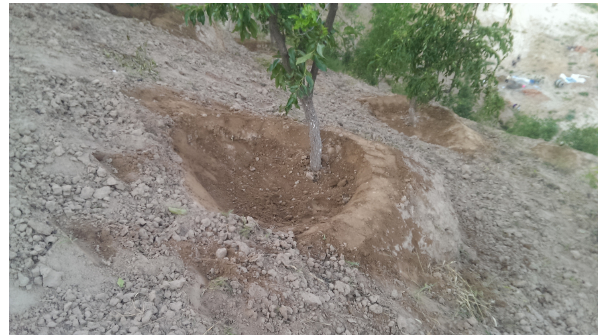
Figure 1. A photo of a fish-scale